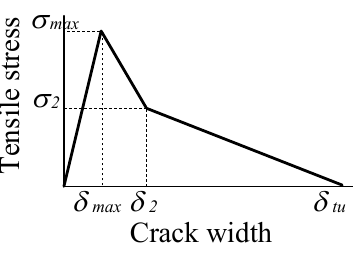
Figure 8. Tri-linear model for bridging law of PVA-FRCC [31].